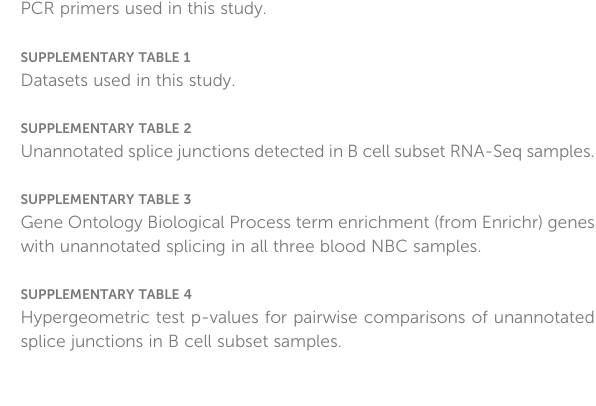
SUPPLEMENTARY TABLE 1 Datasets used in this